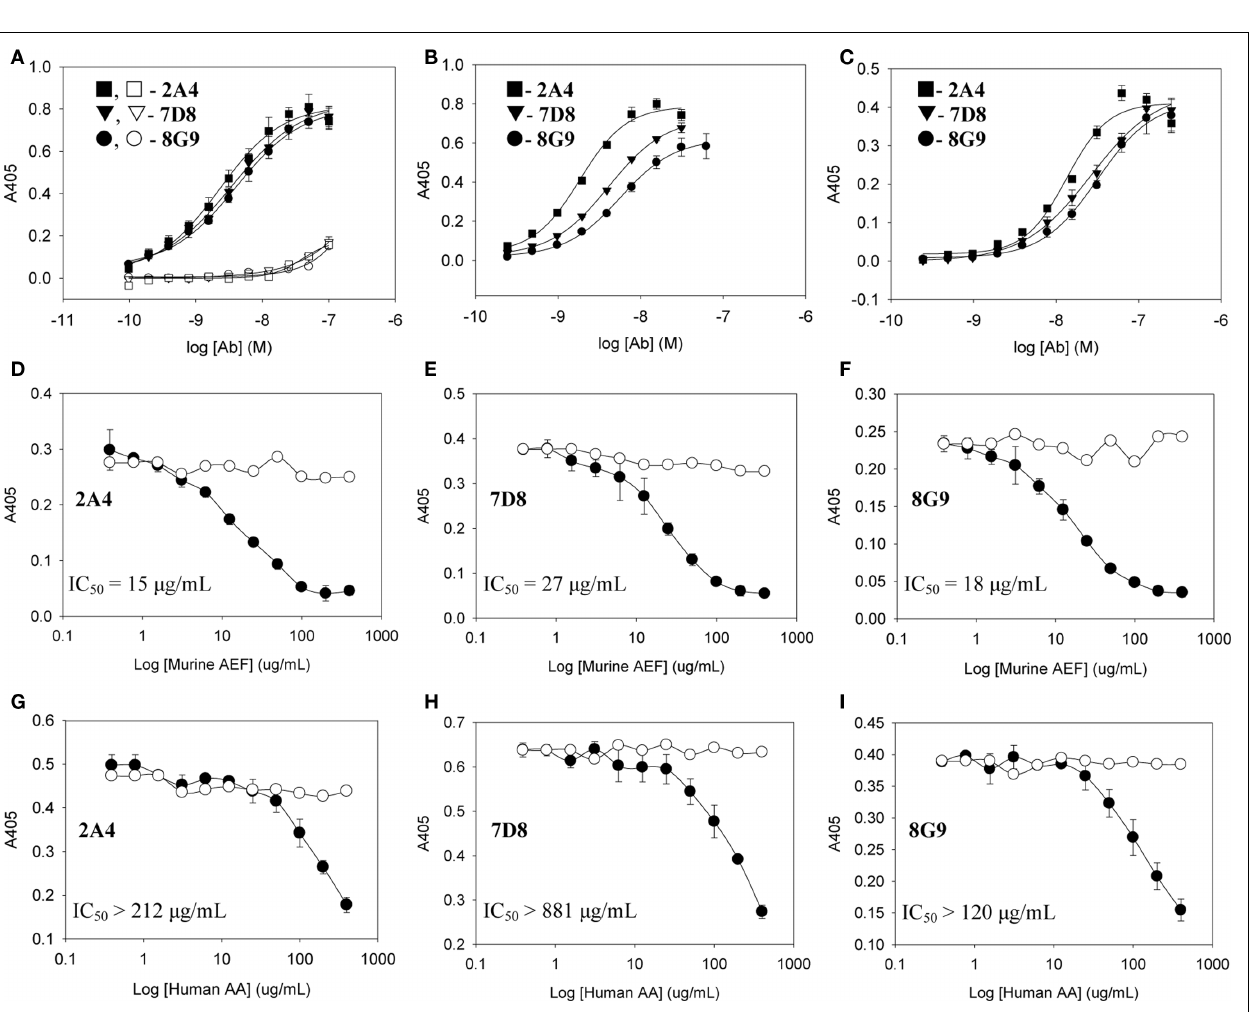
the three mAbs with murine or human AA amyloid extracts, respectively. (D–F) Competitive inhibition of binding of mAbs 2A4, 7D8, and 8G9 to human ◦ • and (G–I) murine AA amyloid in the absence ( ) or presence ( ) of increasing concentrations of the heterologous AA